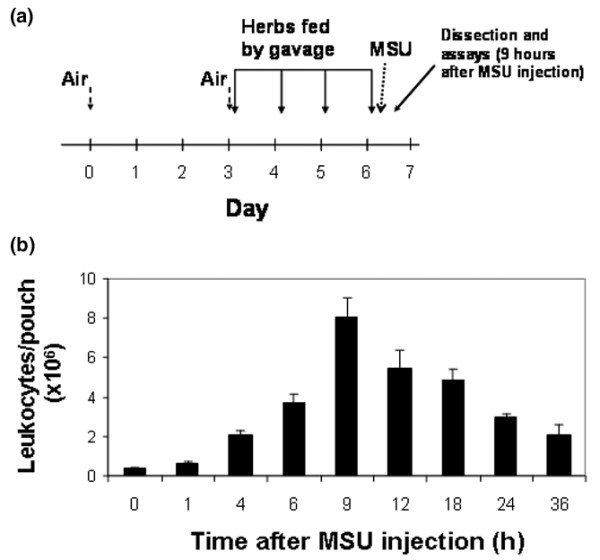
Sequence of events in the murine air pouch model (a) Outline of a typical experiment. Air is injected subcutaneously on day 0 and repeated on day 3, as needed, to keep the pouch inflated. The root extracts or water are gavage-fed once daily on days 3–6. A suspension of MSU crystals in PBS (or PBS only) is injected into the pouch cavity on day 6 after the last gavage feeding. Pouch exudate and tissue are obtained for analysis 9 hours after crystal injection. (b) Determination of the time of maximal inflammation. The MSU crystal suspension was injected into the pouch at 0 hours. Leukocyte counts in the pouch exudate were determined by manual cell counting at the indicated time points (n = 4 mice for each time point). MSU, monosodium urate; PBS, phosphate-buffered saline.